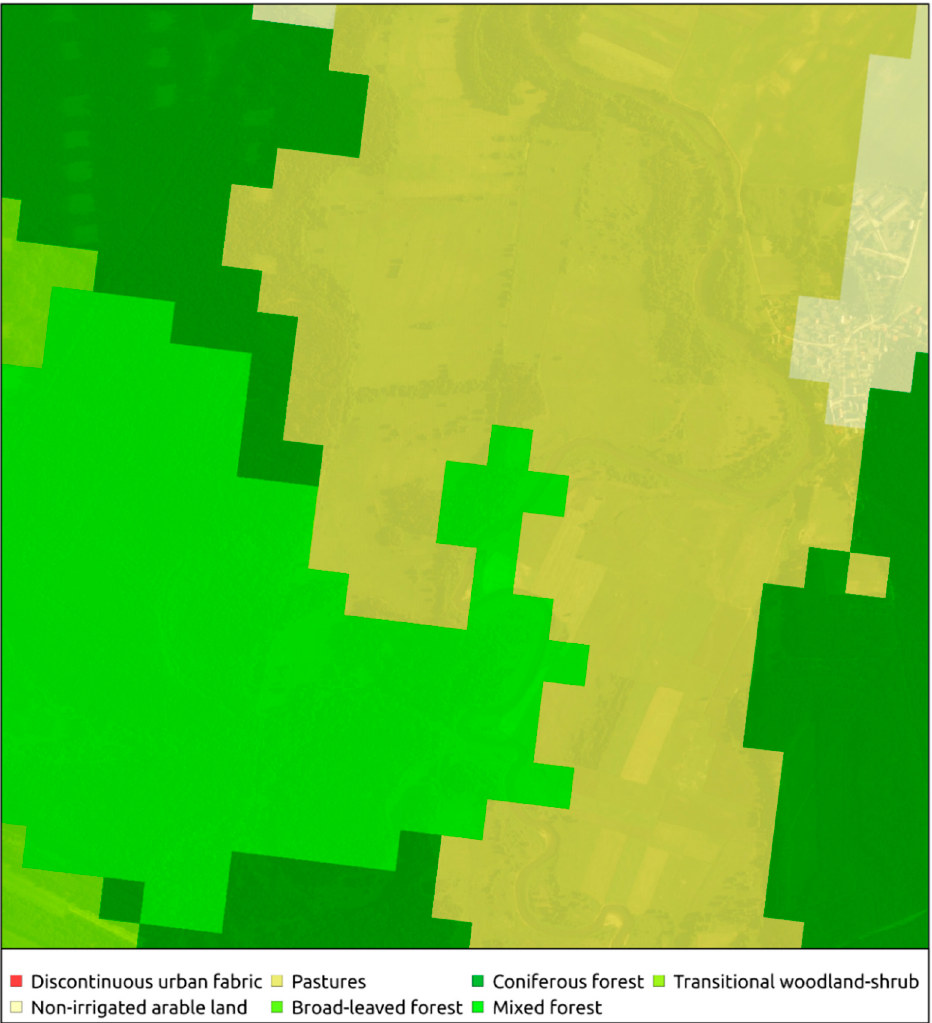
Figure 10. Orthophoto sheet 72961_840430_M-34-40-B-a-2-3 and Corine Land Cover Project (2018) segmentation [66].